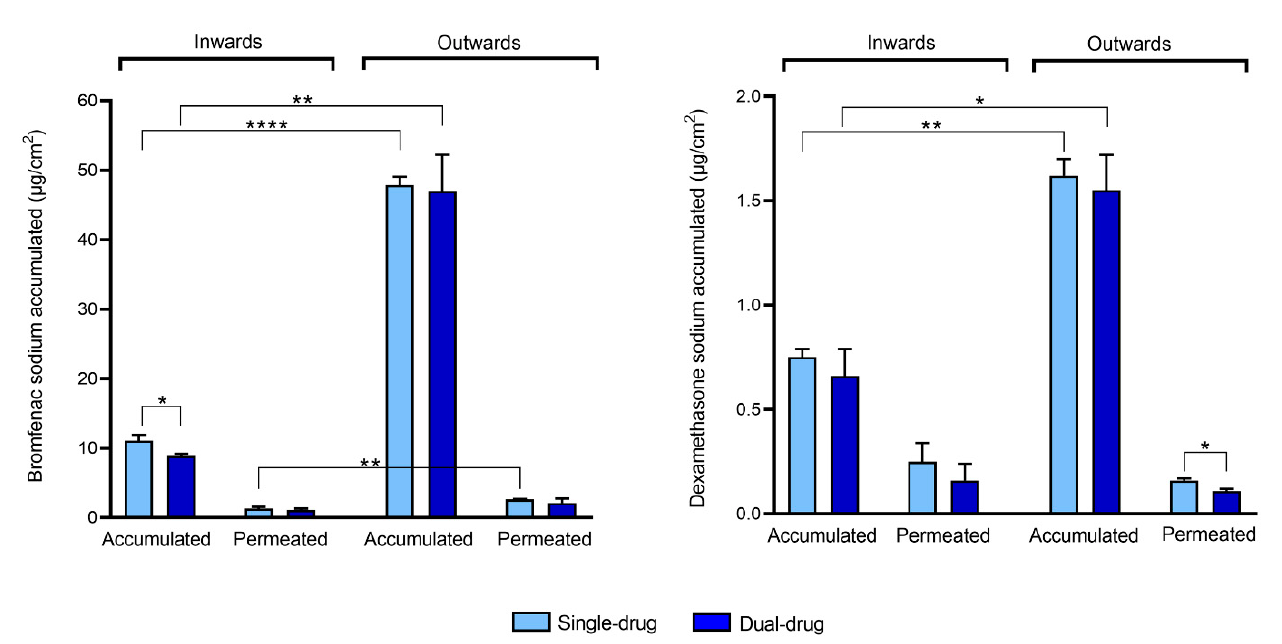
Figure 5. Bromfenac sodium ( left ) and dexamethasone sodium ( right ) accumulated in the cornea and permeated to the receptor chamber (normalized per unit area) in an inward or outward corneal configuration when tested as a single-drug solution (Single-drug) or dual-drug solution (Dual-drug). Mean values and standard deviations ( n = 3); t -test * p < 0.05; ** p < 0.01; **** p < 0.0001.